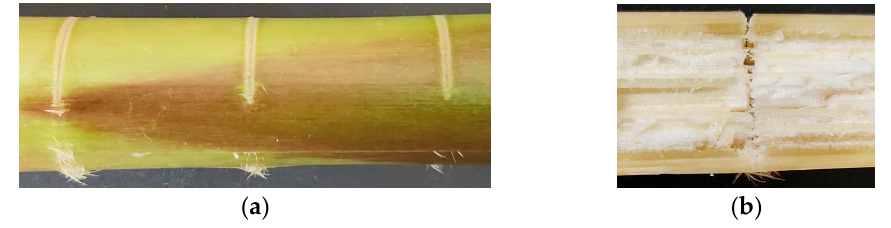
Figure 9. E ff ects of water jet cu tt ing on the stem. ( a ) Outside the stem. ( b ) Inside the